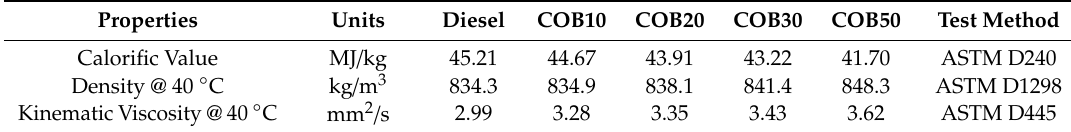
Table 2. Fuel properties of the diesel and biodiesel